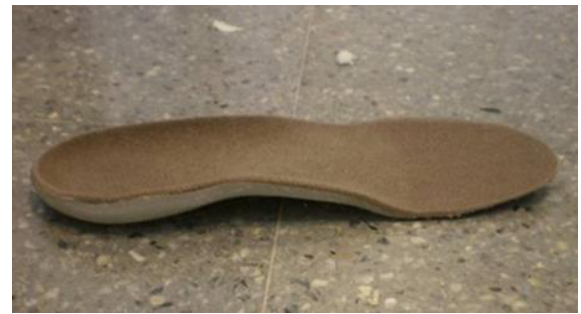
Figure 1. Type of orthotic device administered.